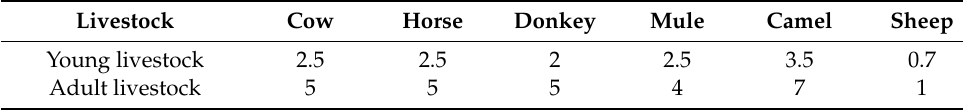
Table 1. The coefficient of one sheep unit for livestock. Livestock Cow Horse Donkey Mule Camel Sheep Young livestock 2.5 2.5 2 2.5 3.5 0.7 Adult livestock 5 5 5 4 7